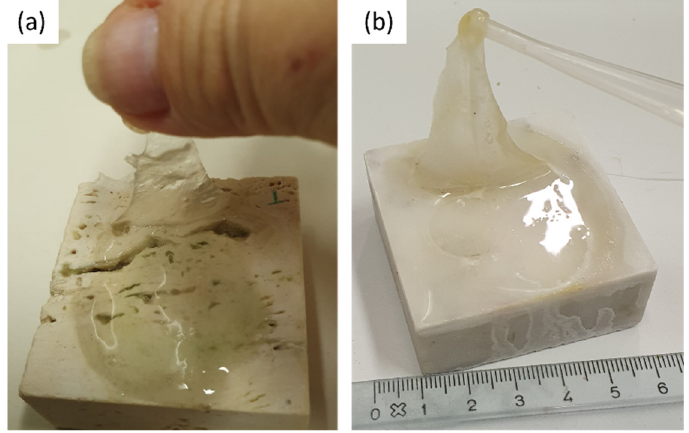
Figure 10. PVA-PEO-borax hydrogel peeling from ( a ) Travertine surface and ( b ) Carrara marble surface.